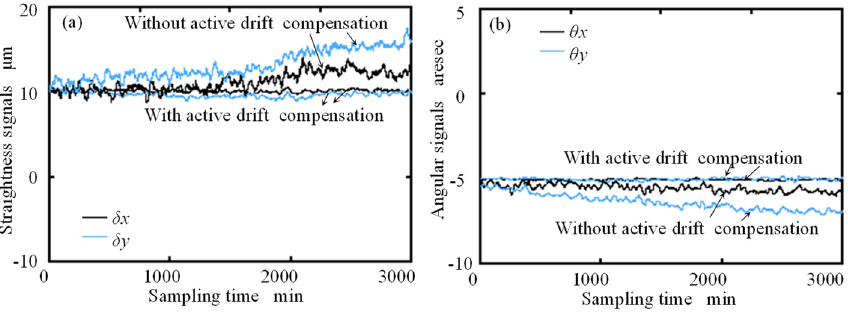
Figure 13. Stability tests of ( a ) the straightness signals and ( b ) the angular signals measured by the detector and the comparison unit when s 2 = s 3 = 50 mm.